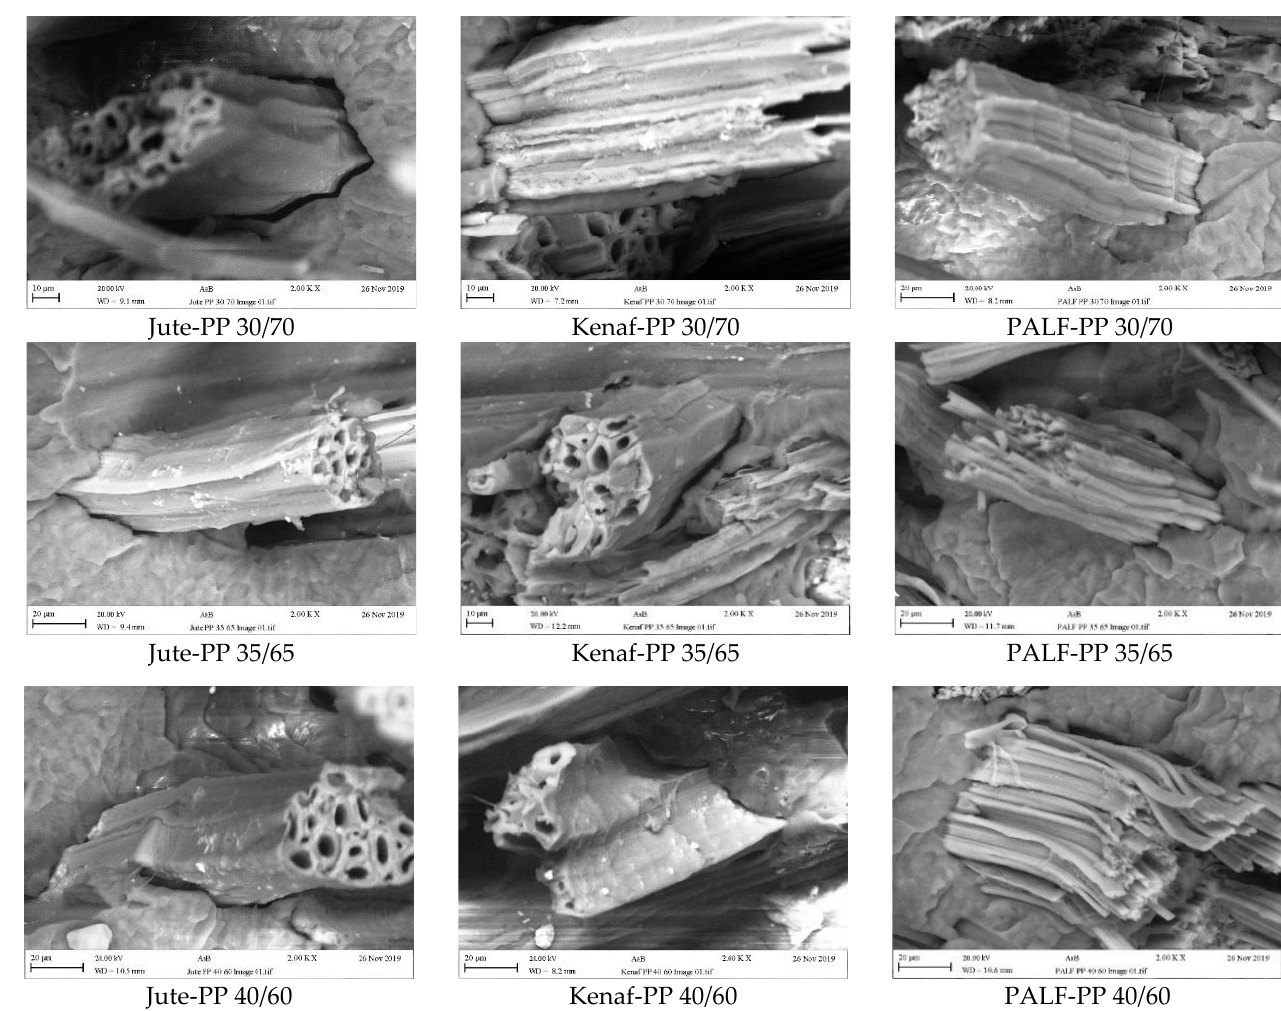
PALF-PP 40/60 Figure 12. SEM images of fractured composites reinforced with different wt.% of jute, kenaf and PLAF fibers. Closer look at the interface at high magnification also revealed gaps between the fi- bers and the matrix for all composites (Figure 13). However, the gap was relatively smaller